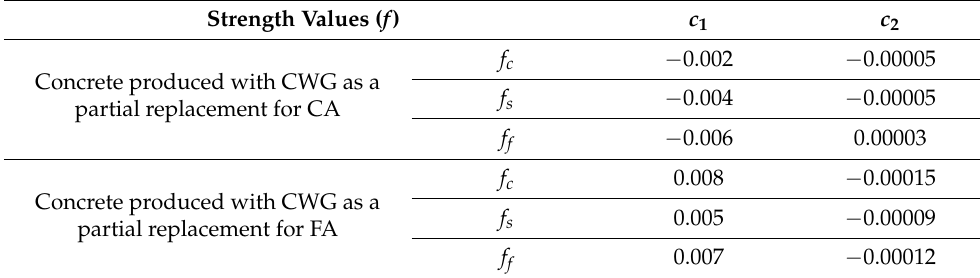
Table 2. The parameters used in Equation